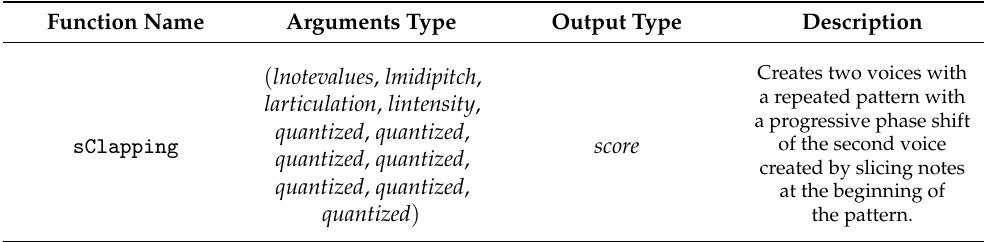
Table 6. Data structure of the genotype function sClapping , a new function generated after flattening the functional tree of Clapping Music shown in Listing